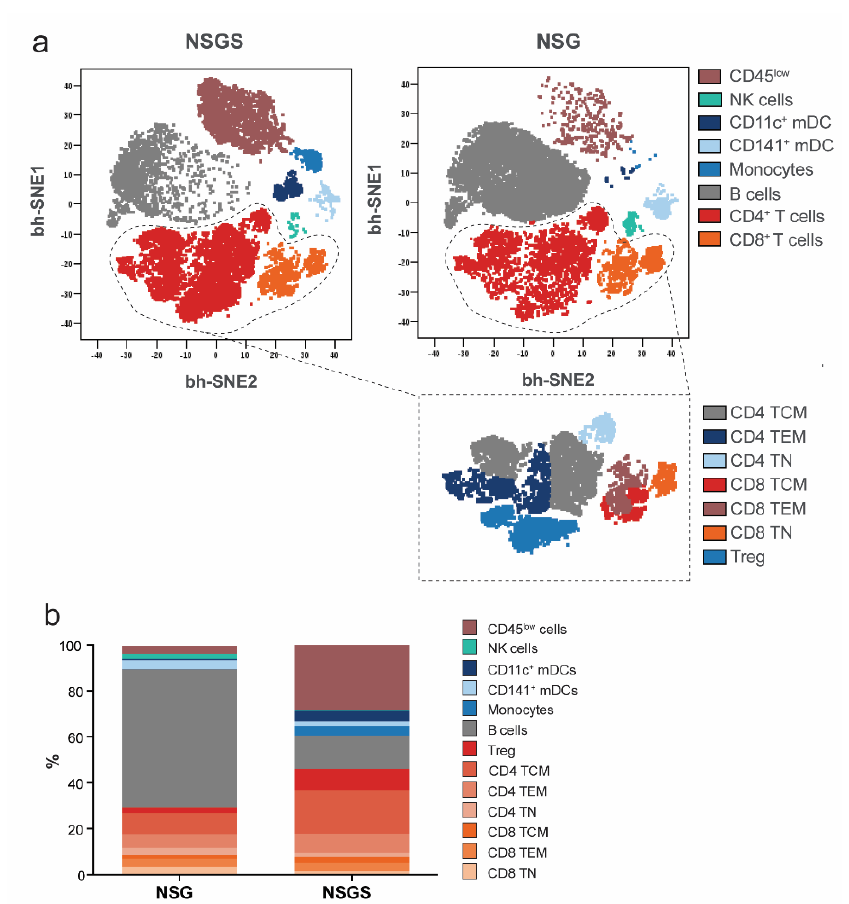
Figure 3. Characterization of peripheral human immune cell subsets in NSG and NSGS mice with mass cytometry. ( a ) Overlay of manually gated cell clusters on viSNE maps. ( b ) Comparisons of all immune cell subset frequencies from NSG and NSGS humanized mice ( n = 3/each). T cell differentiation defined as: naïve (TN), CD45RO − CD95 − CCR7 + CD62L + ; central memory (TCM), CD45RO + CD95 + CCR7 + CD62L + ; effector memory (TEM), CD45RO + CD95 + CCR7 − CD62L − ; regulatory T cell (Treg), CD4 + CD127 − CD25 + CTLA-4 +.